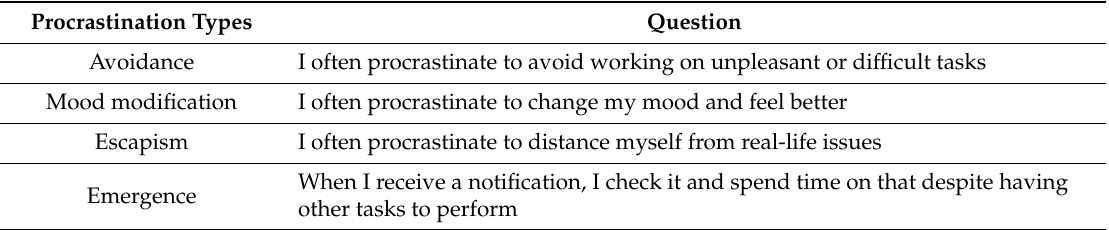
Table 3. Procrastination